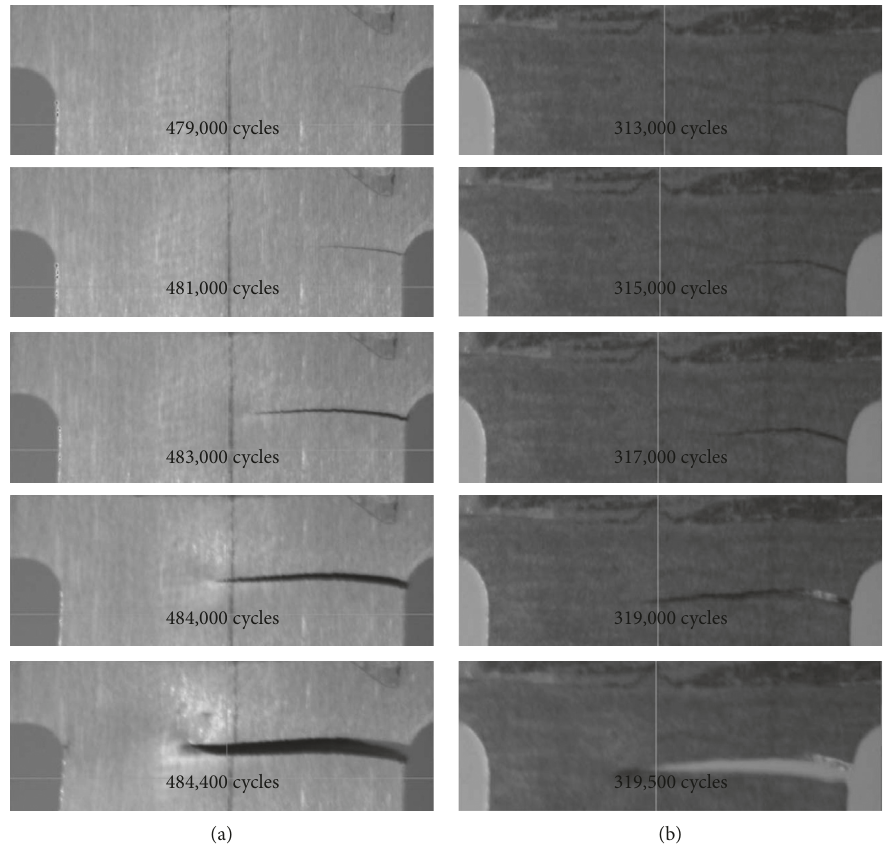
Figure 13: Fatigue crack growth evolution in fillet samples: (a) AR; (b)